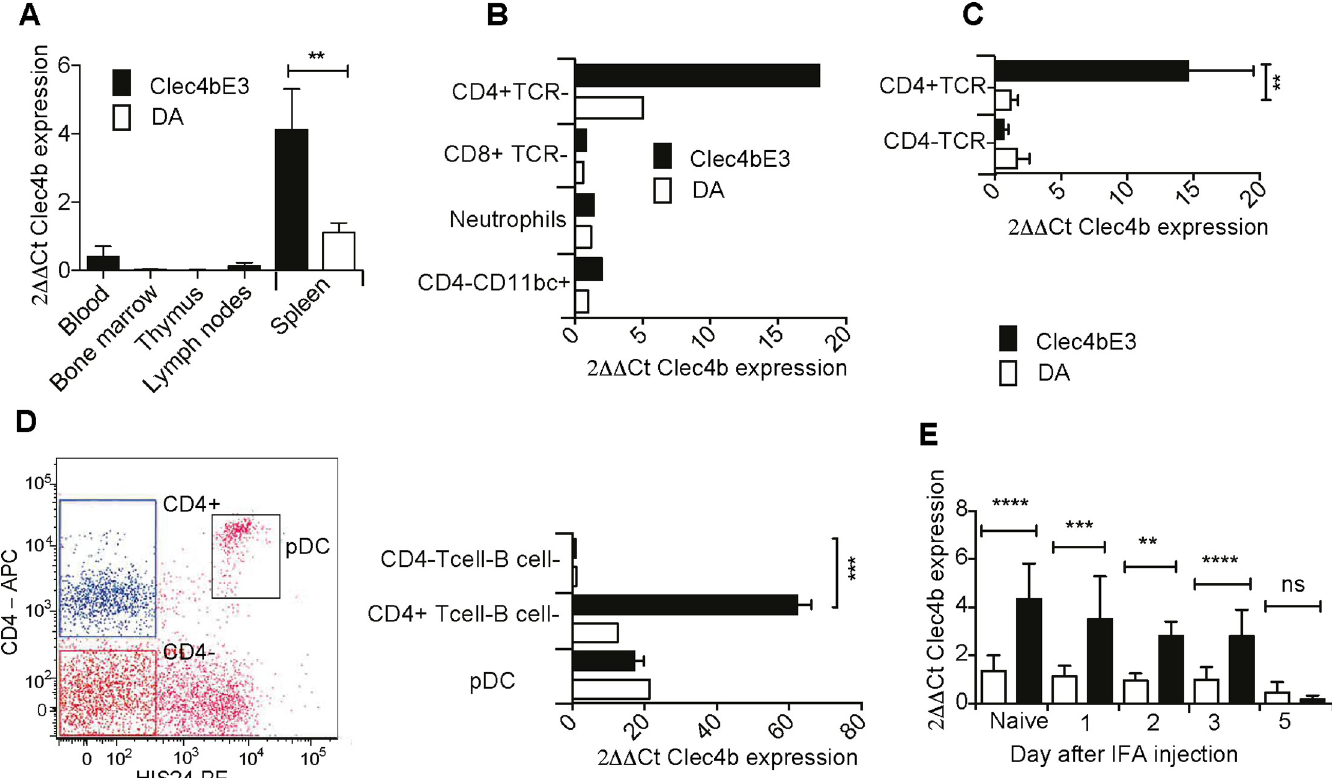
Fig 2. Clec4b expression is restricted to immature CD4+ myeloid cells in the spleen. a) Relative expression of Clec4b in five na ï ve immune-related tissue; spleen, blood, thymus, bone-marrow and inguinal lymph nodes ( n = 5 for spleen and thymus, remaining tissues n = 3 ). b) Clec4b expression of na ï ve spleen cells. The samples were pooled from three different spleens. Cells were first negatively selected for TCR, and then positively selected for CD4 + and CD8 + cells, respectively. After CD4/CD8 sorting, the remaining cells were selected for CD11b/c. Neutrophils were enriched from blood using Ficoll-Hypaque centrifugation. c) Non-pooled spleen samples were negatively selected for T cells and positively for CD4. The CD4- fraction is the flow-through cell ( n = 5 ). d) Relative Clec4b expression in three na ï ve Clec4b E3 or one DA sample, all sorted with a Mo-flow FACS sorter. The FACS plot depicts the gating strategy for the three assessed population. Before CD4 and His24 (CD45R), the population determining gating, the cells were negatively sorted by gating for TCR and CD45RA, eliminating T cells and B cells. The cells were His24 - CD4 + (CD4+ DC), His24 - CD4 - (CD4 - DC) or His24 + CD4 + (pDCs) ( n = 3 for Clec4b E3 and n = 1 for DA). e) Relative Clec4b expression in na ï ve and oil-primed splenocytes selected for TCR-CD4+ and for day 0, day 1 day 2, day 3, and day 5 after oil injection. n = 5 for all groups. Significance stars depict Mann. Whitney Test � = p < 0 . 05 , �� = p < 0 . 01 , ��� = p < 0 . 001 and